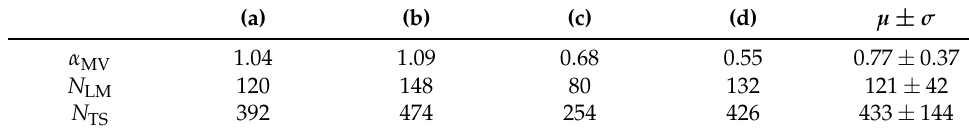
Figure 2. Kinetic networks of the local minima and transition states of the weakly-disordered square ensembles ( a – d ) illustrated in Figure 1. The two-fold degenerate ground states are indicated by red circles. Additional hubs are indicated by orange circles. The highlighted black segments correspond to the transition which leads from a given minimum to a minimum having a lower or equal energy by involving the smallest energy barrier. The number of local minima and transition states of each NP ensemble can be found in Table 1. Table 1. Ground-state microvortex angle α MV , number of local minima N LM and number of transition states N TS of the WDSL ensembles illustrated in Figure 1. The corresponding averages µ and standard deviations σ are obtained from 100 different realizations of